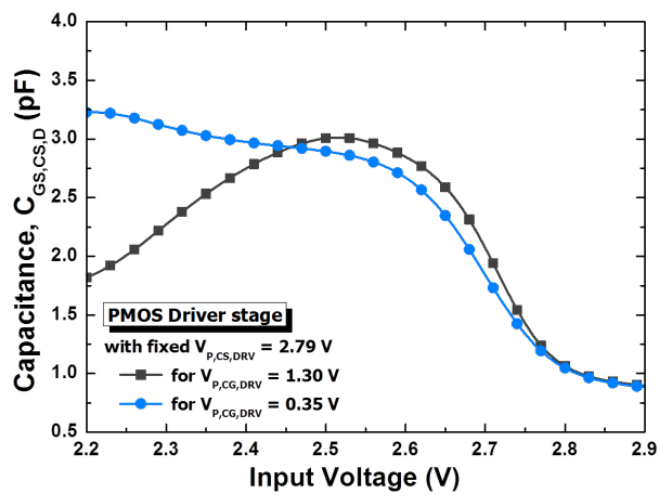
Figure 12. Simulated C GS,CS,D according to the input voltage, V G,CS of the PMOS driver stage with 1.30 V and 0.35 V of V P,CG,DRV (V DD = 3.3 V).